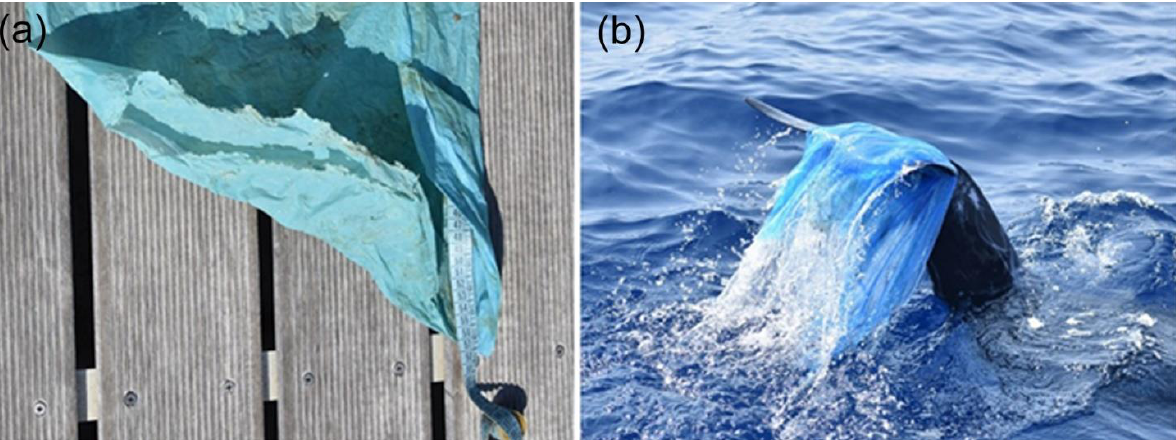
Figure 5. A 58 cm long plastic bag collected during a sighting in July 2019, with clear signs of bites ( a ); a large plastic bag photographed on the flukes of an individual during a sighting in September 2019 ( b